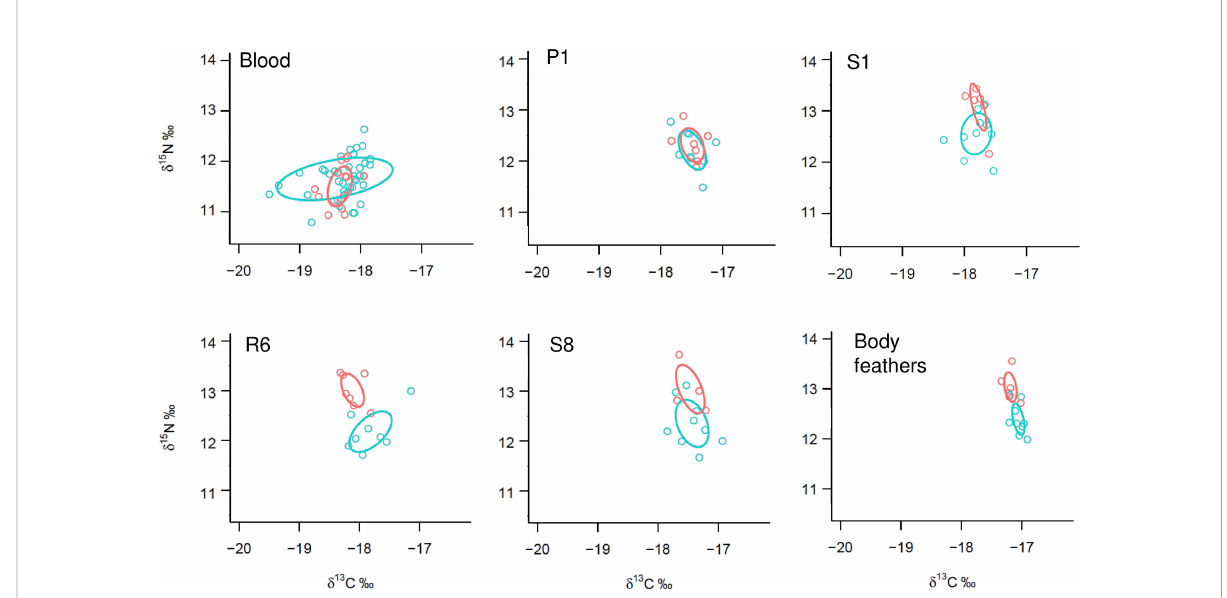
FIGURE 4 Comparison of the Bayesian Ellipses for stable isotopes of carbon and nitrogen for the hot (orange) and cool (blue) populations of Cape Verde storm-petrels. Stable isotopes were sampled for the breeding areas from blood and the fi rst primary feather (P1), and for the non-breeding areas from the fi rst secondary feather (S1), sixth rectrix (R6), eighth secondary feather (S8) and body feathers. Sample sizes are summarized in Appendix